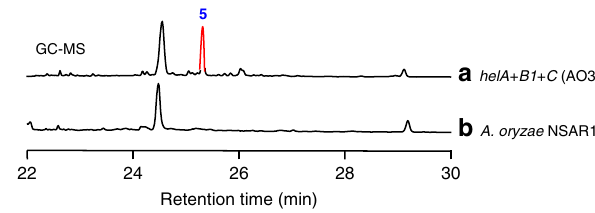
Fig. 3 GC – MS analysis of mycelia extract. a A. oryzae harboring helA , helB1 and helC ; b A. oryzae